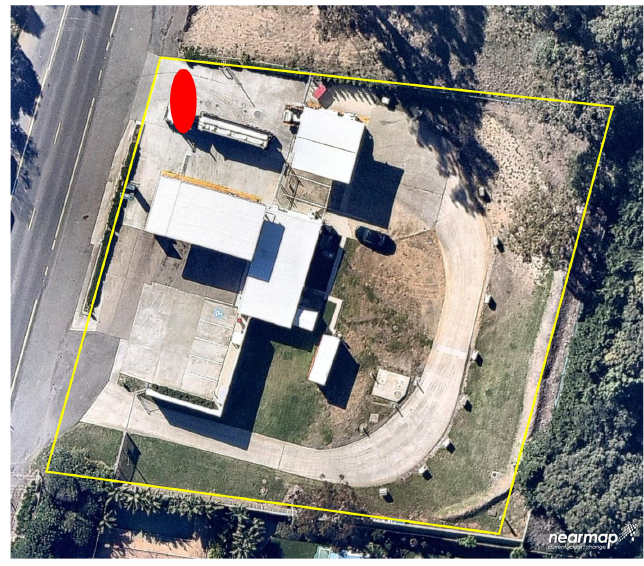
Figure 3. Aerial Photograph of Bomaderry site with approximate property boundary shown by yellow line.